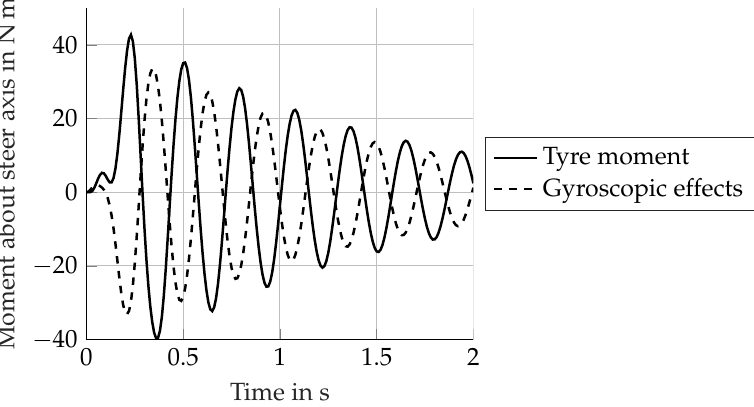
Figure 13. Front wheel gyroscopic effects and tyre moments about the steering axis. The time simulation was obtained with a lateral force excitation on the motorcycle frame at the speed of 150kmh − 1